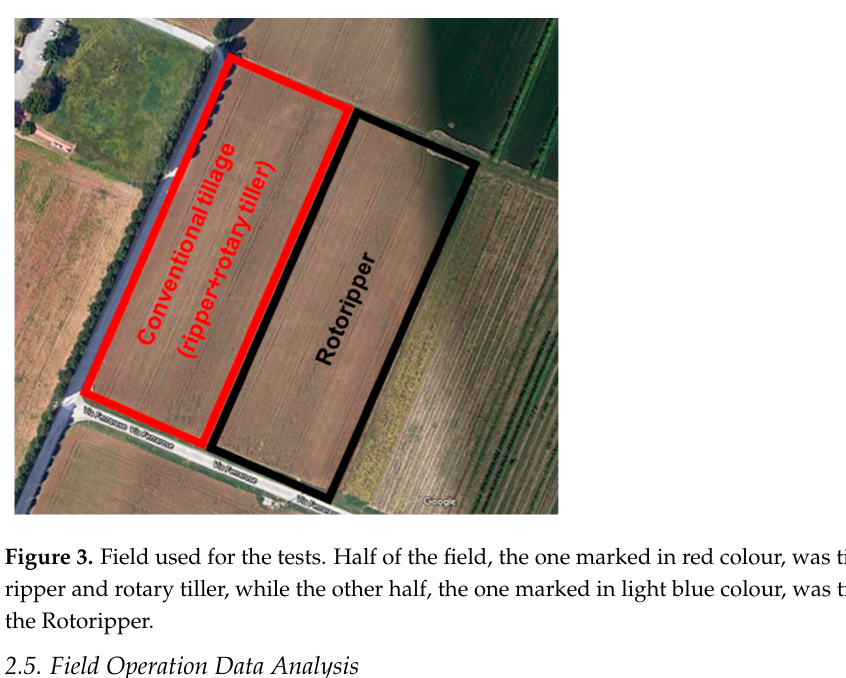
( b ) Figure 5. Mean values of operational and environmental indexes F c ( a ) and f ha ( b ).